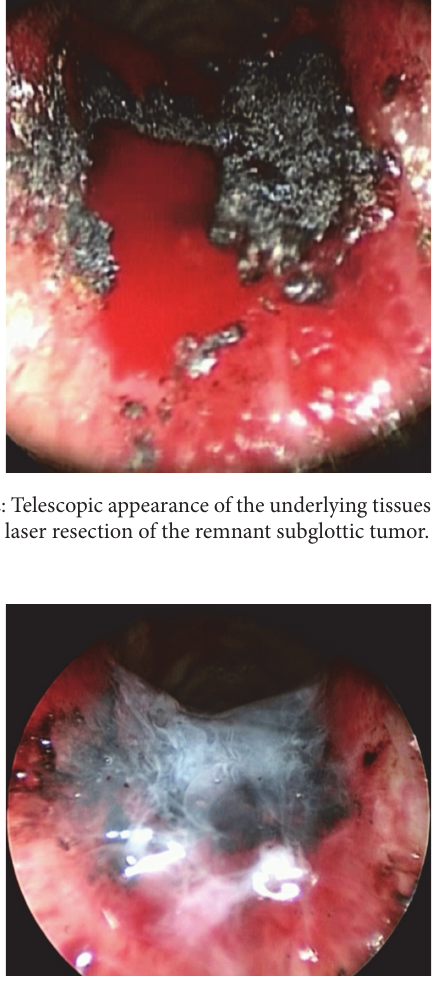
Figure 3: Appearance of the subglottis following the first fibrin sealant